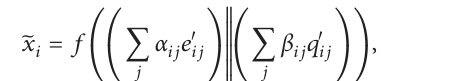
Figure 5 considers shape classification task for point